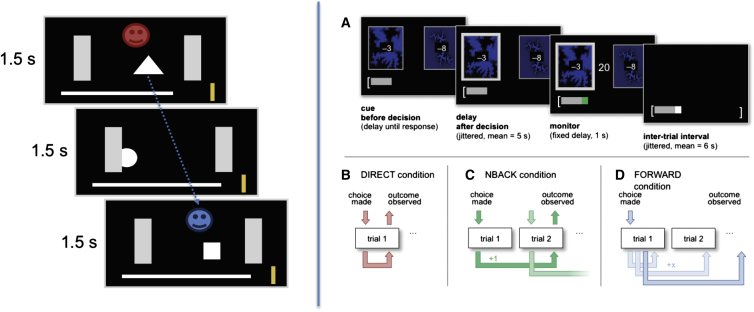
Task SchematicTask schematic for experiment 1 (left) and experiment 2 (right).